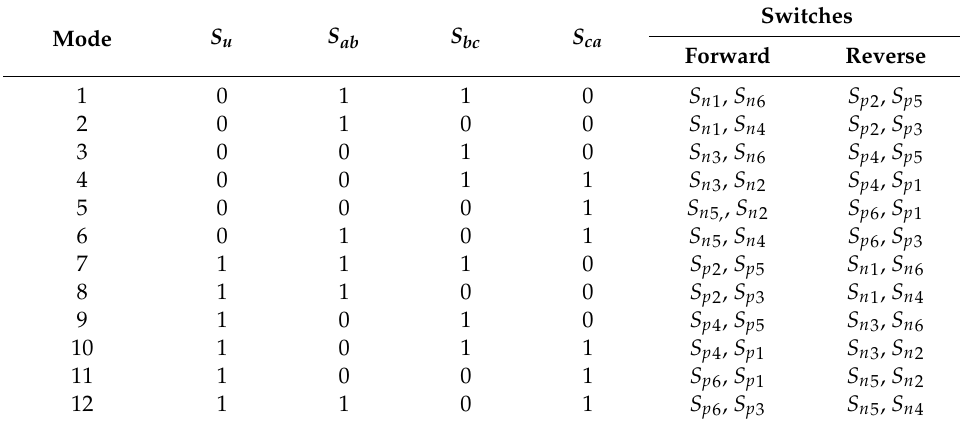
Table 1. Twelve operating states of the matrix